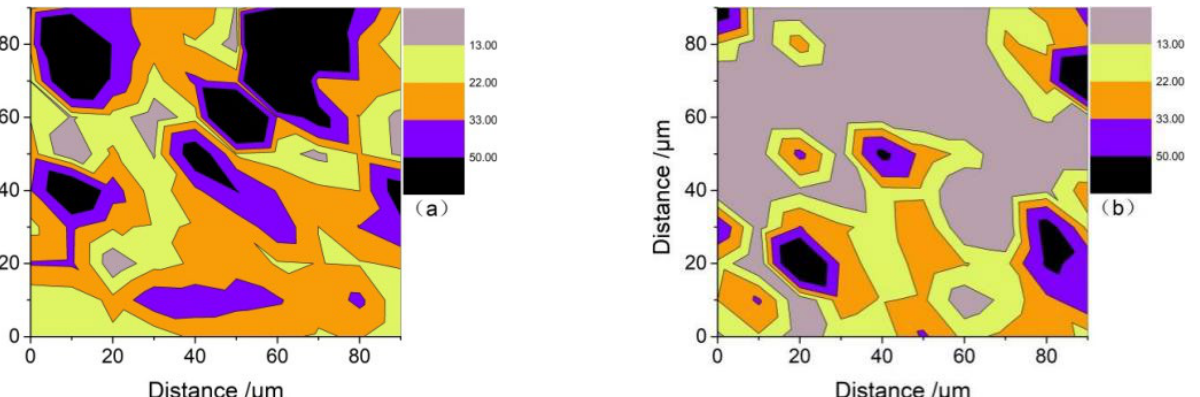
Figure 16. Frequency distribution and Gaussian peak fitting results of samples at 28 days. ( a ) Con- trol. ( b ) O-L-2.